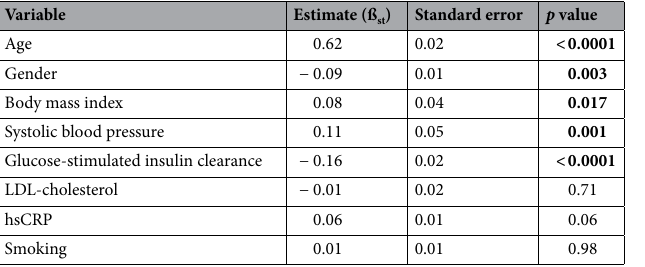
Table 5. Multiple linear regression analysis of variables influencing intima-media thickness including further cardiovascular disease risk factors. A p -value < 0.05 was considered statistically significant and is given with bold